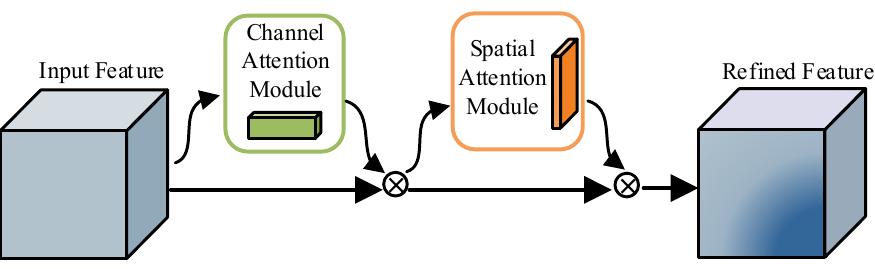
Figure 6. Overview of convolutional block attention module.